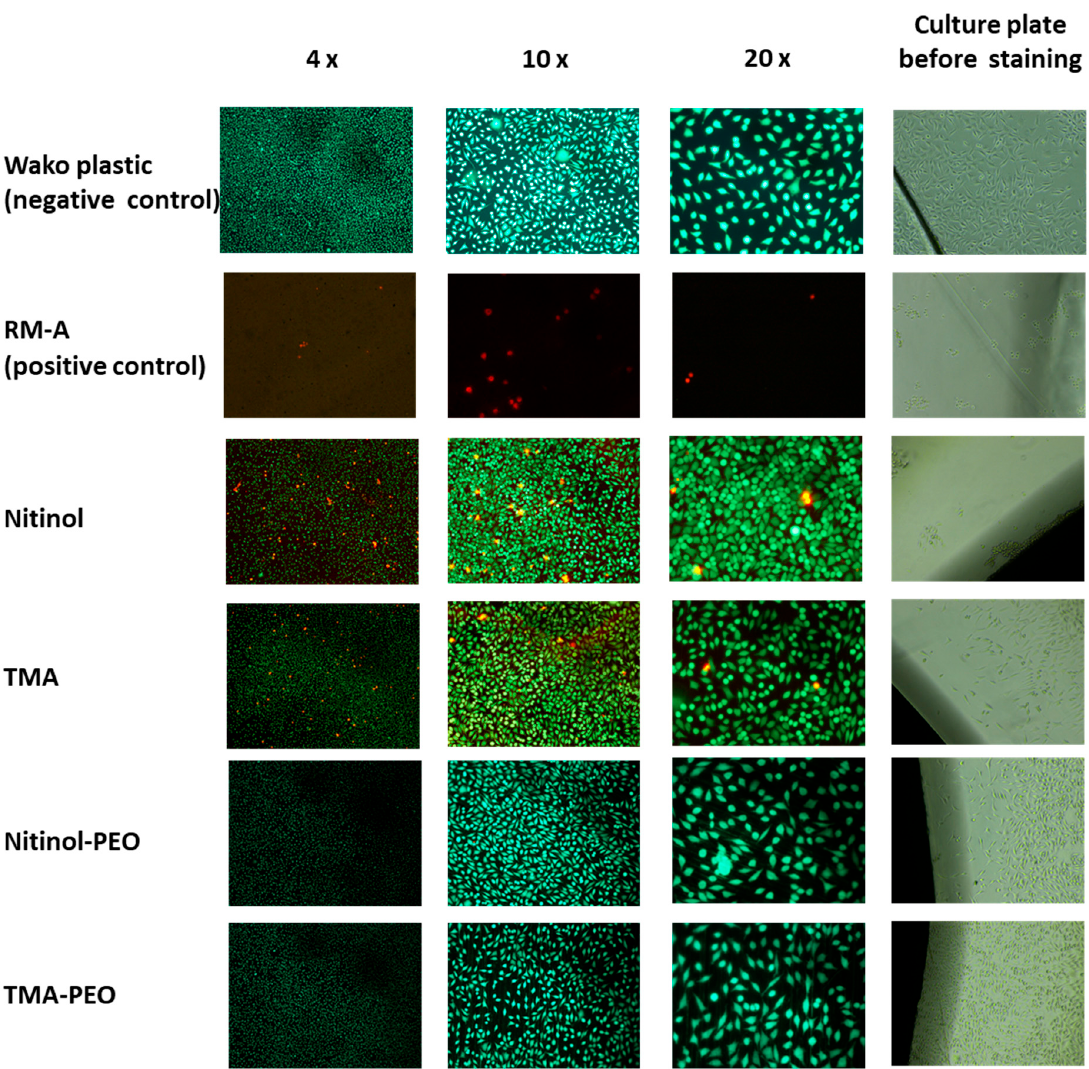
Figure 3. Live–dead staining of both ceramized and untreated NiTi and β -Ti archwires compared to RM-A positive control and WAKO negative control.